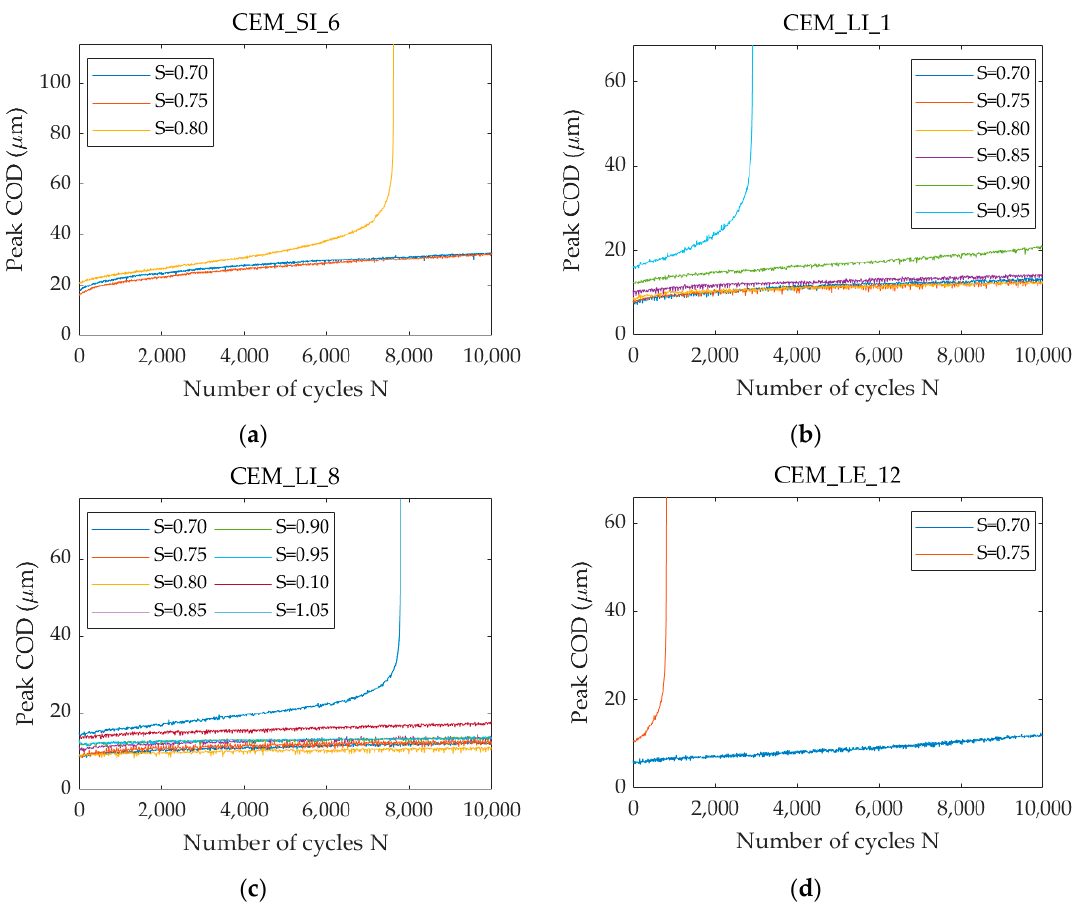
Figure 14. Evolution of the crack opening displacement at the maximum load with increasing number of cycles N with increasing load level S: ( a ) CEM_SI_6; ( b ) CEM_LI_1; ( c ) CEM_LI_8; ( d )